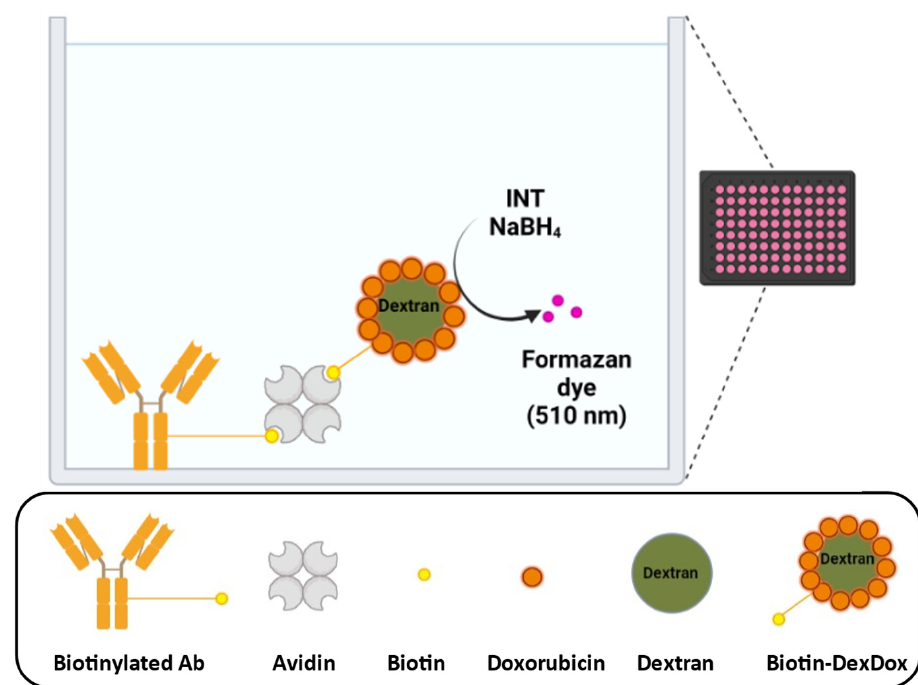
Figure 8. Simplified concept of using Biotin-DexDox for labeling immunoassays via the avidin–biotin system (made by Biorender.com, accessed on 28 January 2023).